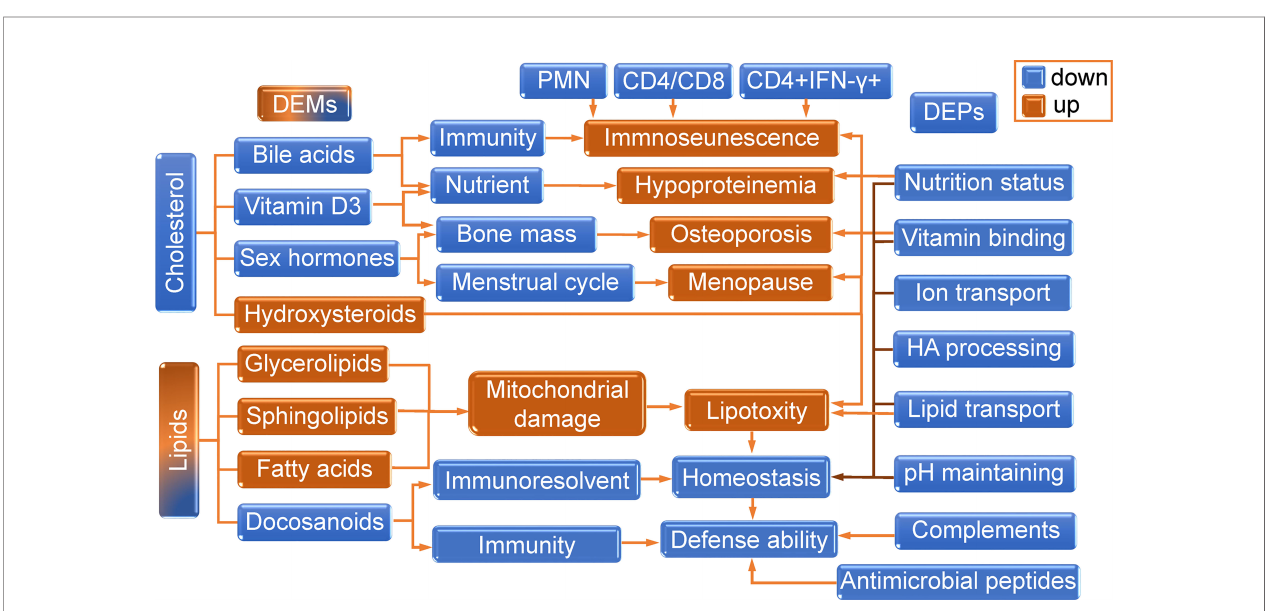
FIGURE 10 | The role of DEPs and DEMs in the aging features of thyrotoxicosis mice. The changes in cholesterol synthesis and metabolism were mainly manifested by the decrease of synthesis and absorption, as well as the increasing conversion to GCs. The decrease of cholesterol, bile acids, pregnane steroids, and VD, as well as excessive GCs, resulted in immunosenescence, osteoporosis, hypoproteinemia, and many other aging related syndromes and diseases. The upregulations of Glycerolipids, Sphingolipids, Fatty Acids were the direct evidence of lipotoxicity. Lipotoxicity is mainly manifested in its damage to the mitochondrial membrane, acting on immune cells leading to immunosenescence, and acting on organs causing organ senescence. GCs are also lipid-like molecules, so the harmful effects of excessive GCs could also be classi fi ed as lipotoxicity. On the contrary, the Docosanoids were downregulated, but correspondingly, their decrease also led to the decline of homeostasis regulation ability and defense ability. Downregulated DEPs led to the reduction of lipids, ions and vitamins transmission and utilization ef fi ciency, resulting in malnutrition, which was the main cause of poor prognosis in the elderly. Downregulated DEPs also contributed to the decline of HA processing and PH maintenance. So, changes in metabolites and proteins together destroyed the balance of homeostasis, which consequently led to the low defense response ability and aging related diseases. The decrease of CD4 +/CD8+ ratio and IFN- g production capacity, together with granulocytopenia represented immunosenescence, and the decrease of complements and antimicrobial peptides also represented the declined immune function, all these performances indicated that the defense ability of thyrotoxicosis mice were declined seriously, which were the main causes of susceptibility to infection in the elderly. In conclusion, the present study proved that malnutrition, immunosenescence, and lipotoxicity were the features and mechanisms of thyrotoxicosis mice simulating the accelerated aging